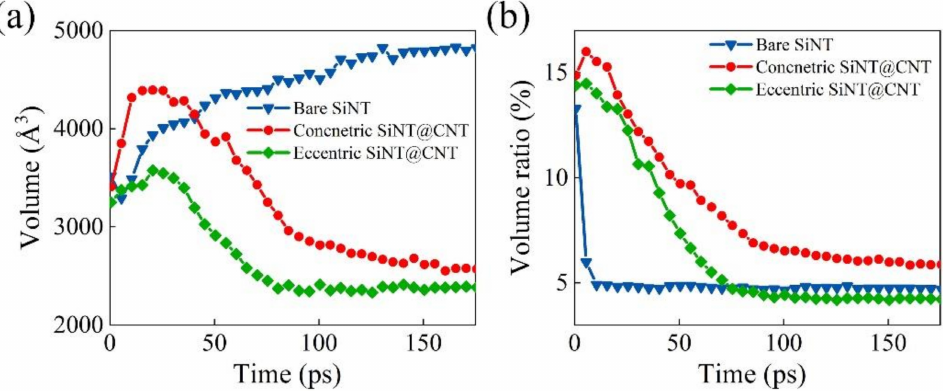
Figure 5. Evolution of inner holes in bare SiNT, concentric SiNT@CNT, and eccentric SiNW@CNT. ( a ) The volume of inner hole changes with time and ( b ) volume ratio (the volume of inner hole/total volume) as a function of time in the lithiation